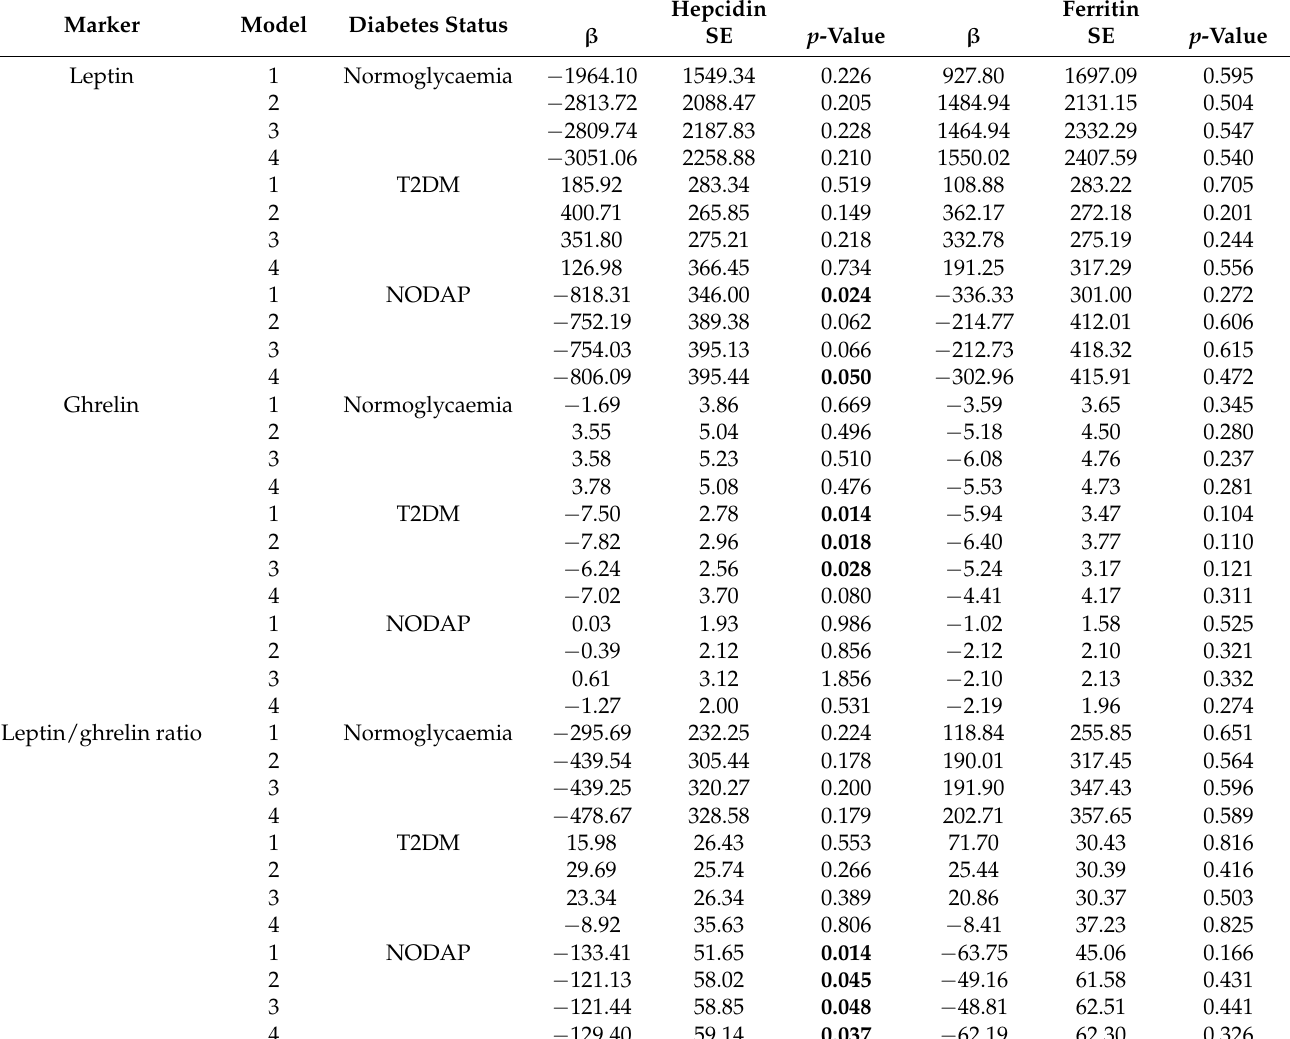
Table 4. Associations between hepcidin, ferritin, and markers of energy balance in the fasted state, stratified by diabetes status.